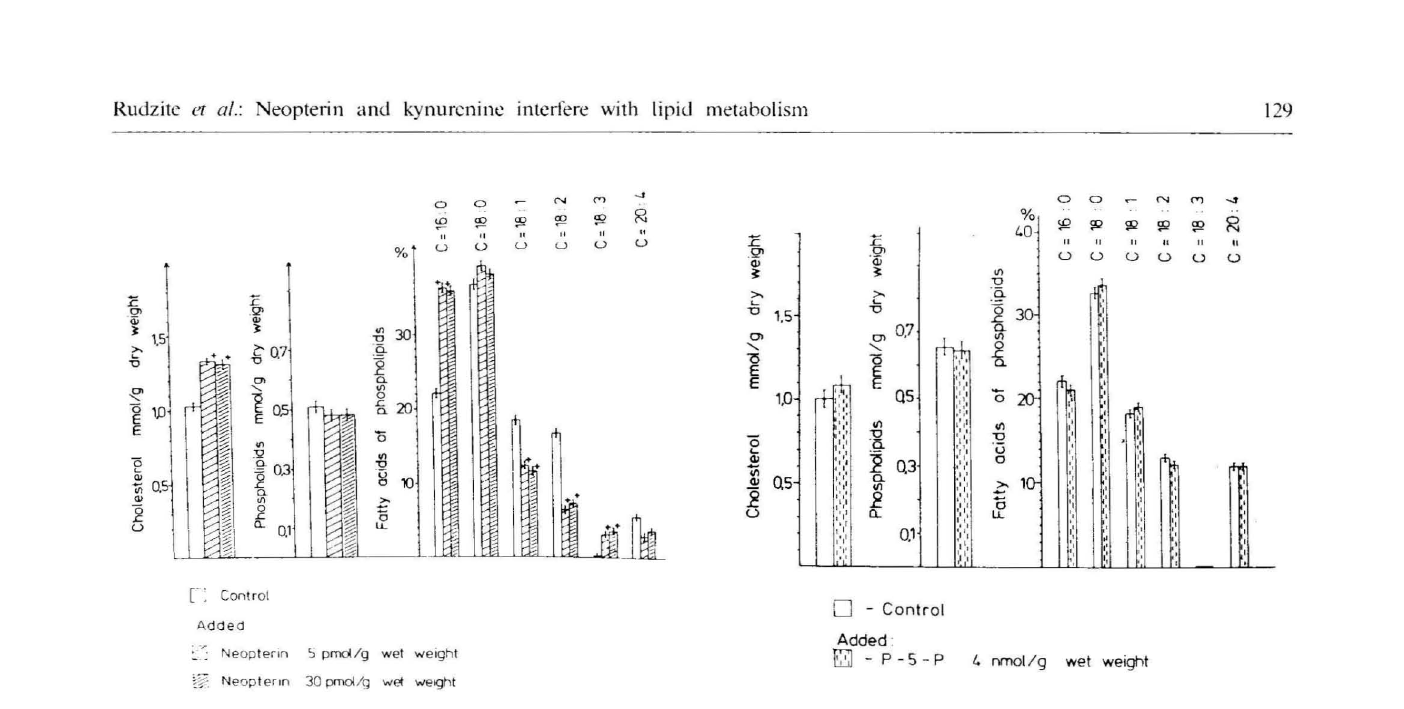
Figure 4. Concentrations (meani: S.D.) of cholesterol and rhosrholirids. as well as fatty acid content (in percent: mean± S.D.) in controls CJ) and samples with 5 pmol/g wet weight D-neopterin (['I), or with 30 pmol D-neopterin/g wet weight (~). Samples of rat liver tissue homogenate were used to test for phospholipid biosynthesis in vitro. Incubation me